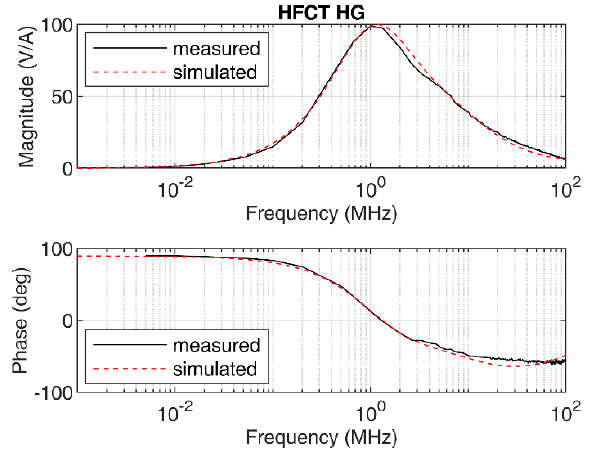
Figure 4. HFCT_HG sensor frequency response, measured and simulated.